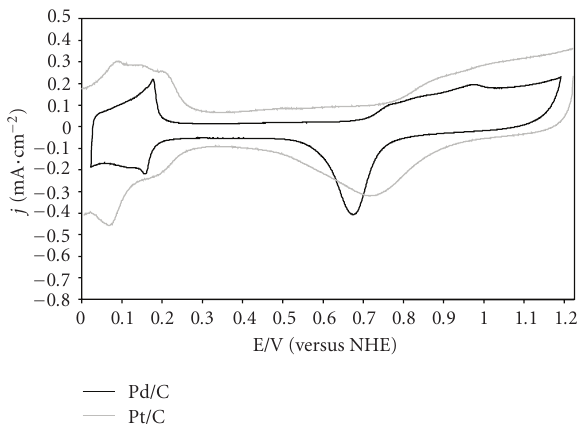
Figure 1: Comparison of cyclic voltammograms of Pd/C and Pt/C in N 2 saturated 0.5MH 2 SO 4 solution at room temperature, scan rate 5mVs − 1 .